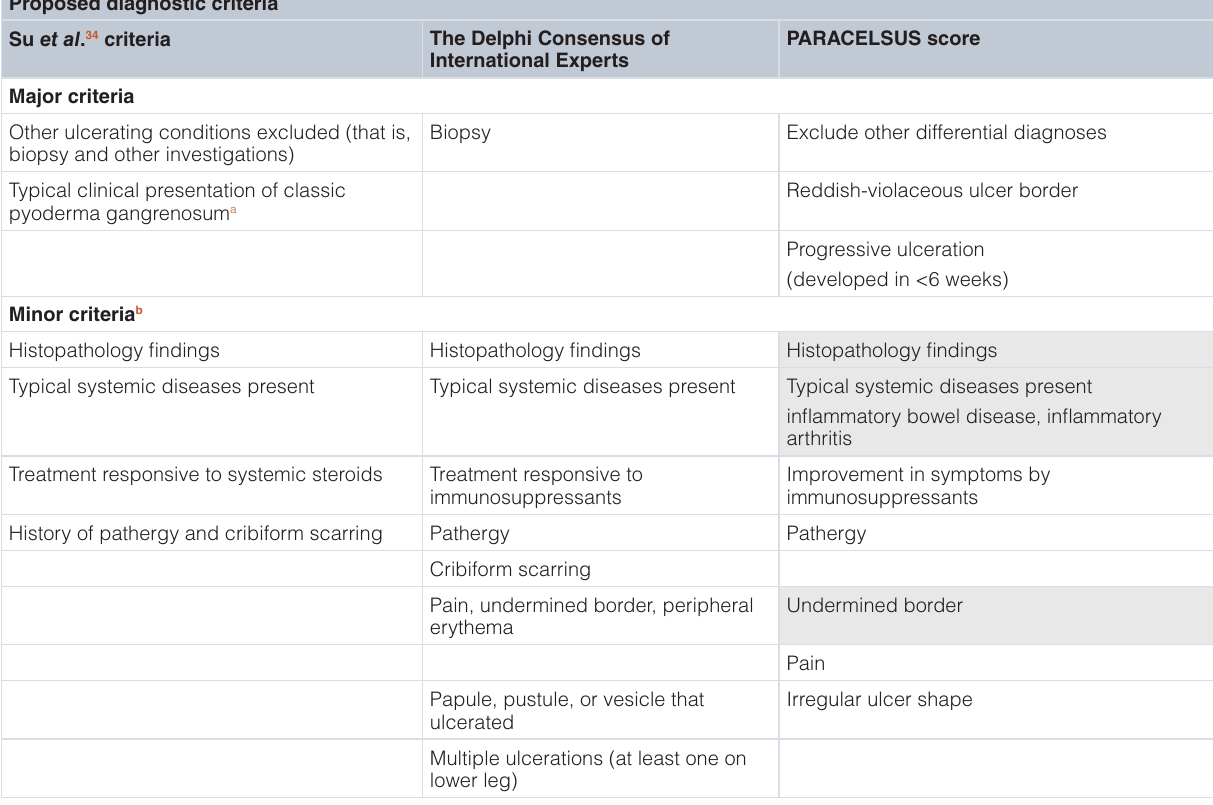
Table 3. Comparison of the different diagnostic criteria suggested for pyoderma gangrenosum 31,34,35 . Proposed diagnostic